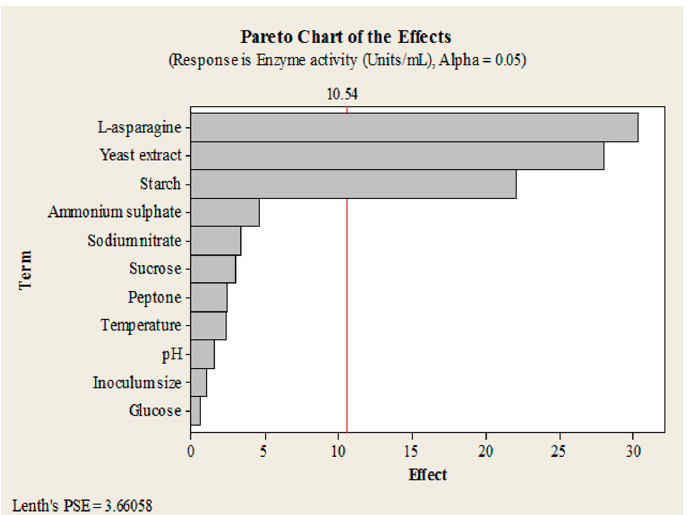
Fig. 1. Pareto chart of the effects of individual variables on L-asparaginase production by endophytic Talaromyces pinophilus in PBD Table 5. The predicted and observed responses along with the CCD design matrix with factors in coded values for L-asparaginase production by endophytic Talaromyces pinophilus Run